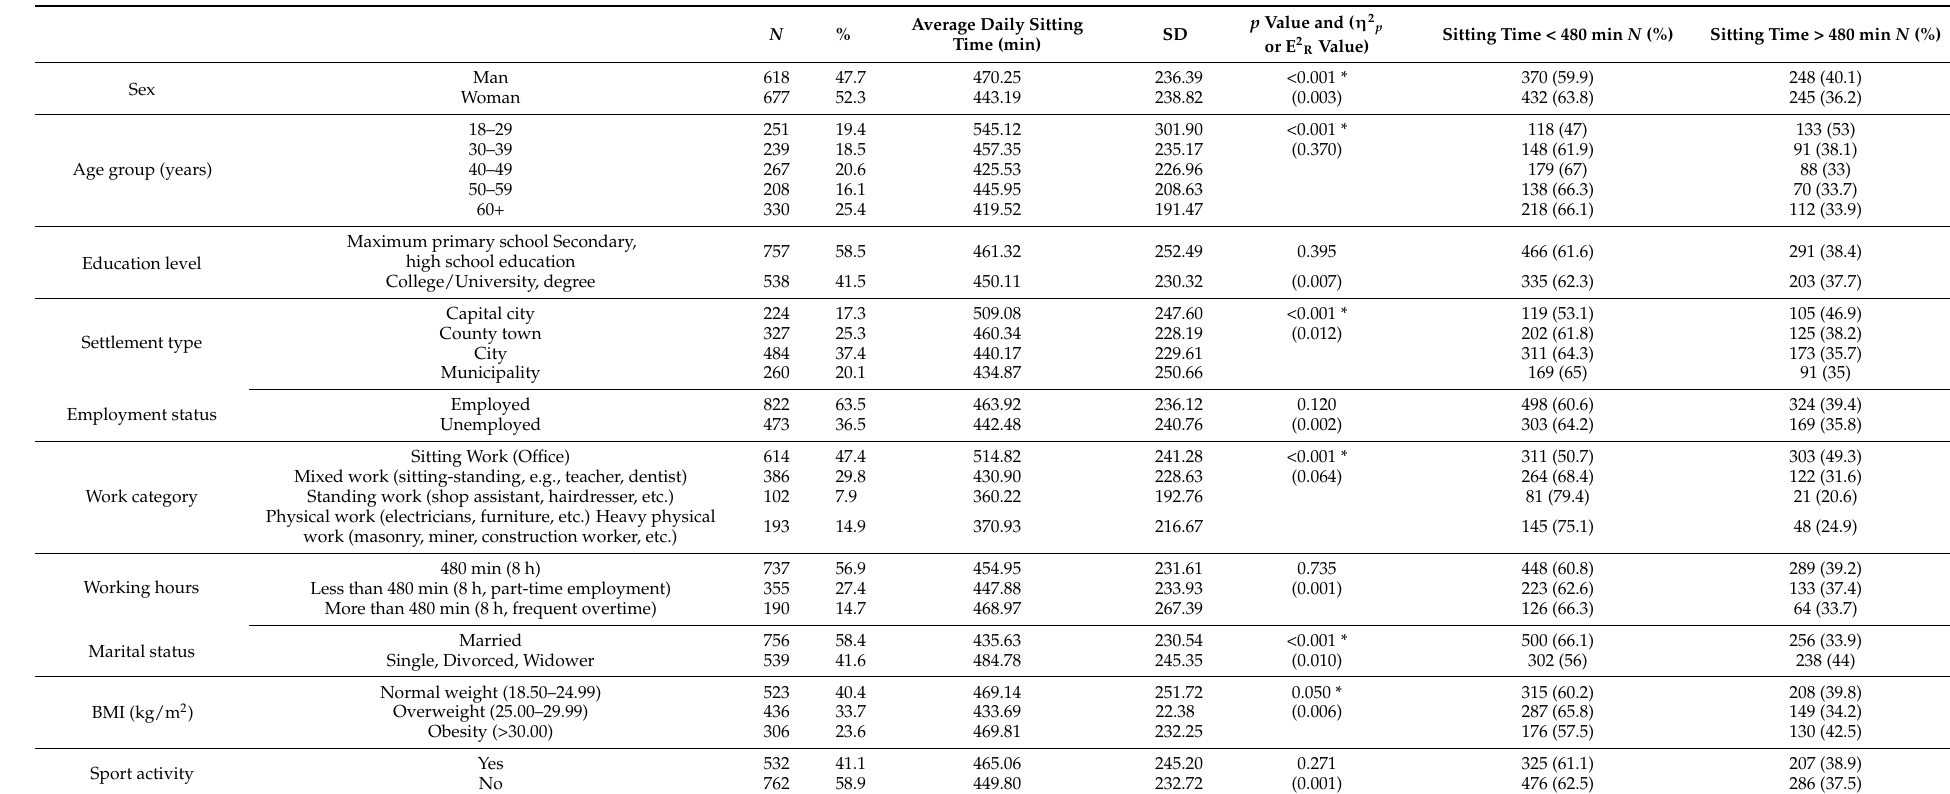
Table 1. Characteristics of the sample and analysis of the variance for daily sitting